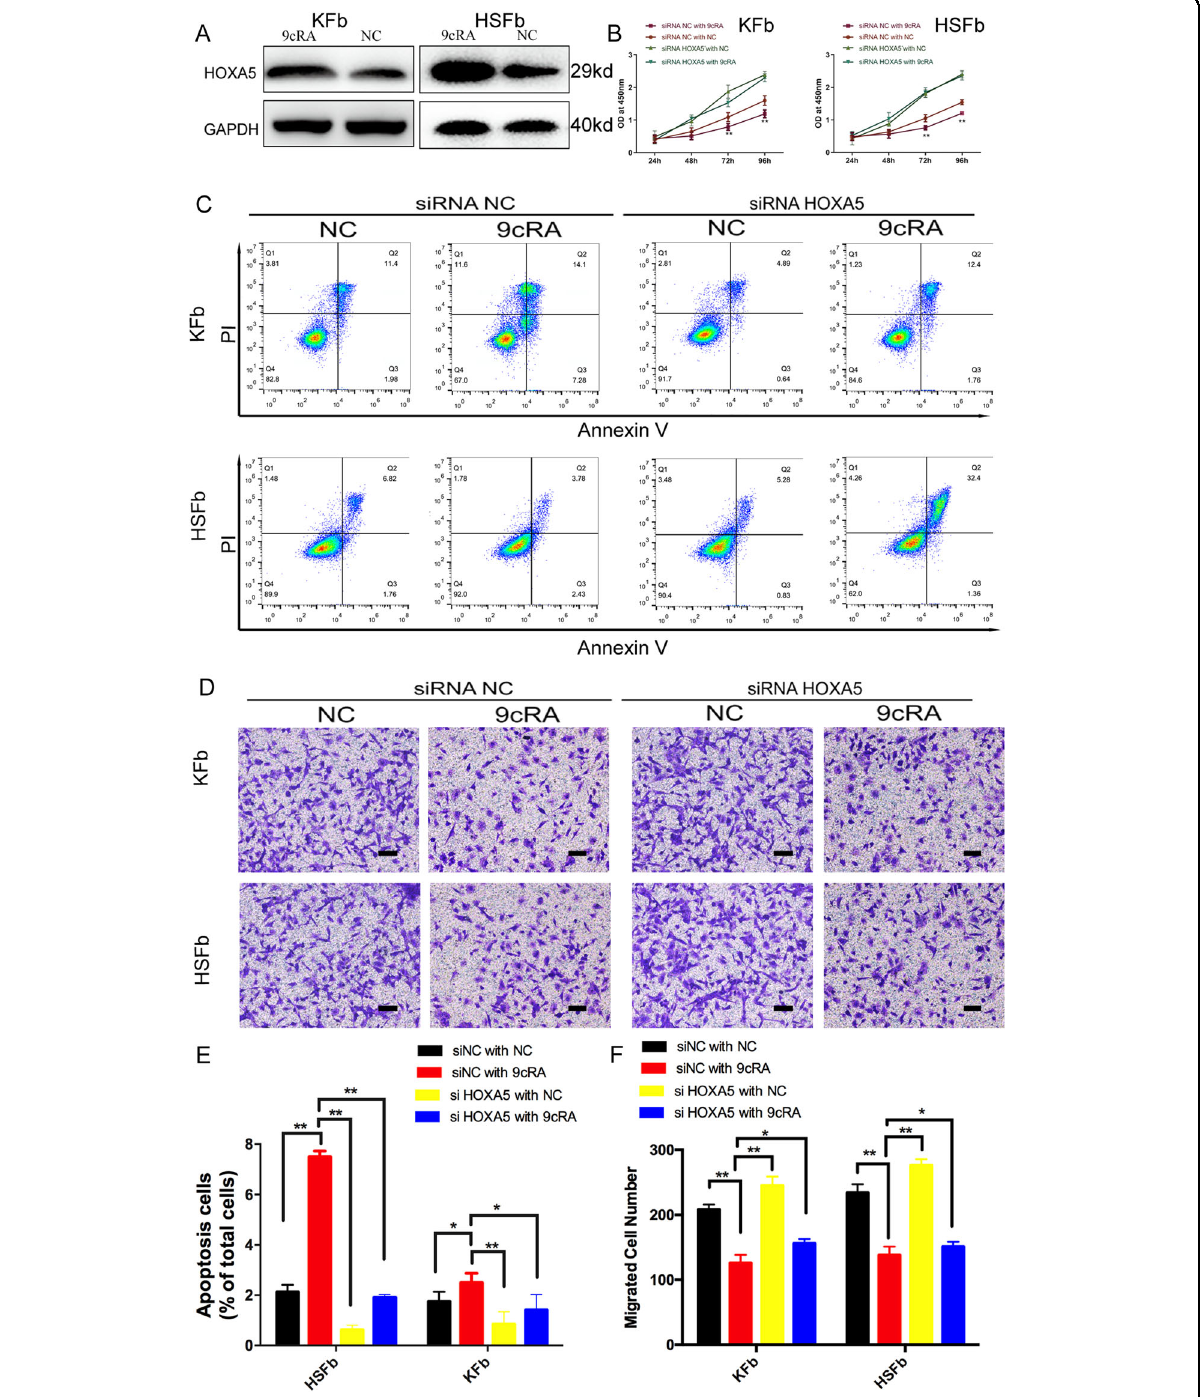
Fig. 6 9-cis-retinoic acid increases HOXA5 expression and promotes HOXA5-mediated effects on HSFb and KFb. A 9-cis-retinoic acid (9cRA) enhanced the expression of HOXA5 in KFb and HSFb. B Knockdown of HOXA5 inhibited the 9cRA-mediated regulation of cell proliferation. C , E Knockdown of HOXA5 inhibited the 9cRA-mediated regulation of cell migration in KFb and HSFb. D , F Knockdown of HOXA5 inhibited the 9cRA- mediated regulation of cell apoptosis in KFb and HSFb. * p < 0.05, ** p < 0.01. scale bar = 100 μ